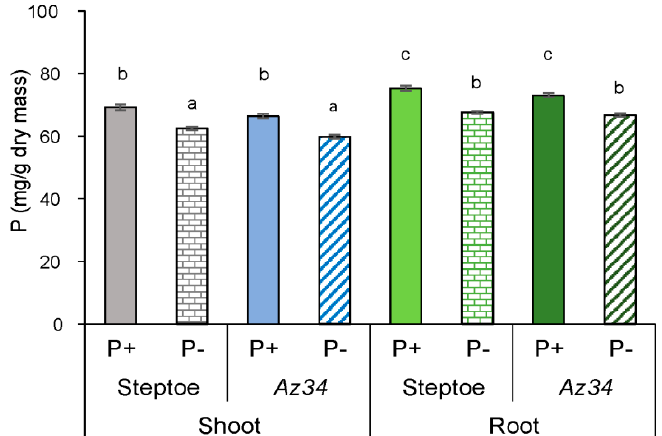
Figure 3. P concentration (mg/g dry mass) in shoots and roots of 4-days-old WT (cv. Steptoe) and Az34 plants grown for 4 days on nutrient solutions with (P+) or without (P − ) phosphate. Means ( n = 6), with significant ( p ≤ 0.05) differences between all genotype/treatment combinations are marked with different letters (ANOVA, LSD).